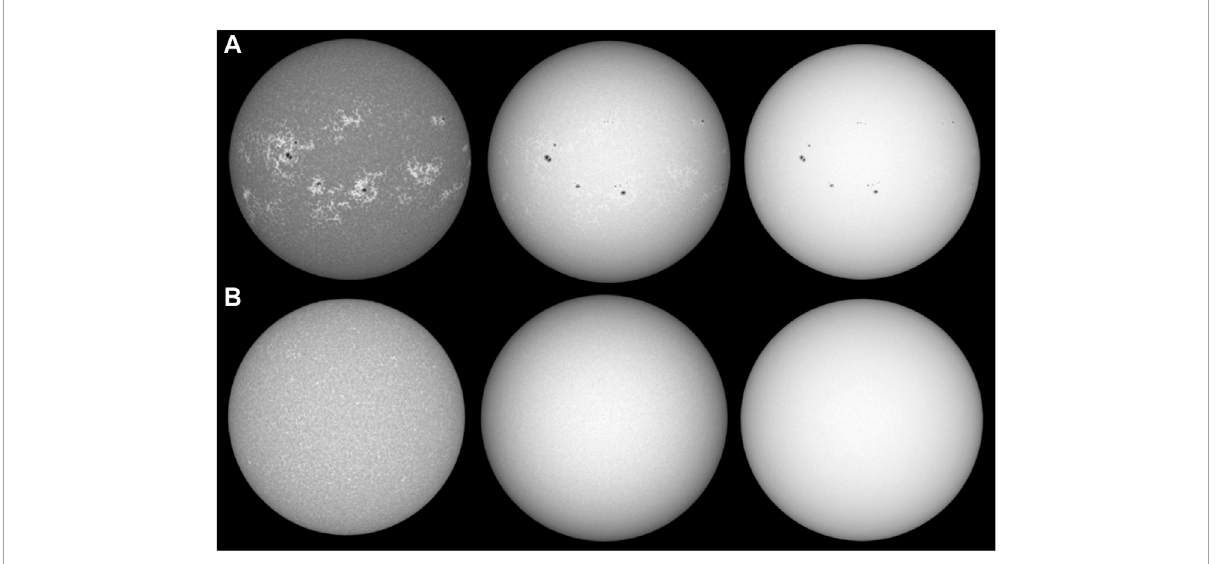
FIGURE 3 Examples of the solar full-disk images obtained with the Rome/PSPT on 13th December 2013 (A) and 30th June 2020 (B) ; from left to right: Ca II K at 393.3 nm (bandwidth 0.25 nm), G-band at 430.6 nm (bandwidth 1.2 nm), and red continuum at 607.2 nm (bandwidth 0.5 nm) images. These images show examples of the routine Rome/PSPT observations after instrumental calibration. The solar disk is shown without compensation for ephemeris.